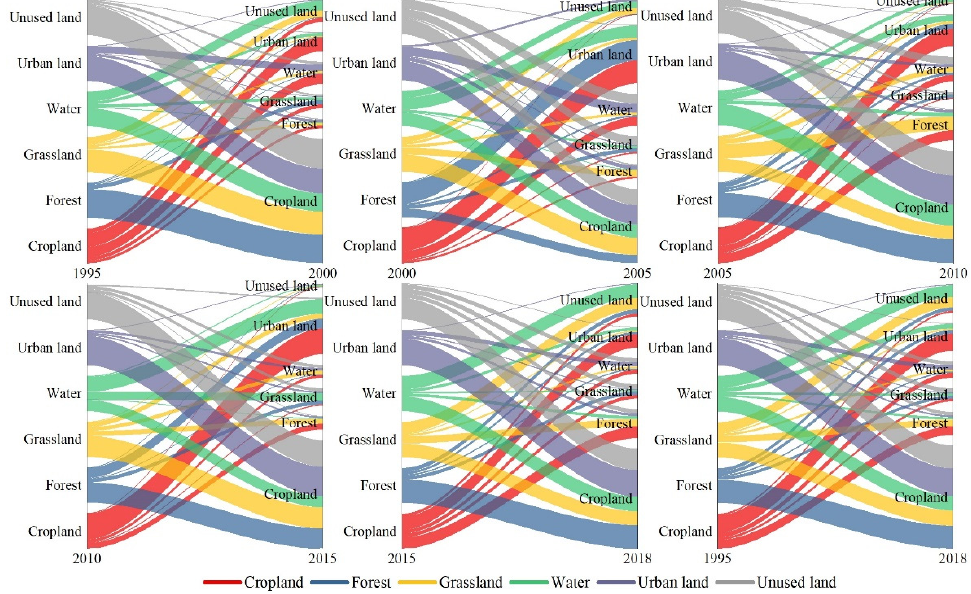
Figure 6. Land-use transfer at the entire level, 1995–2018.